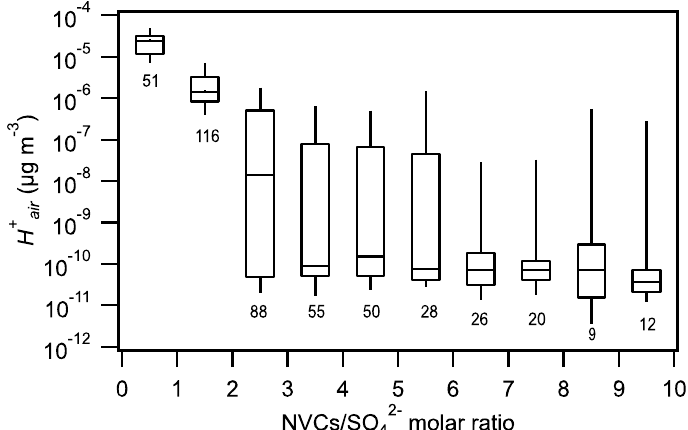
Figure 3. Box plot of 𝐻 (cid:3028)(cid:3036)(cid:3045)(cid:2878) versus the NVCs/SO 42 − molar ratio. The box plot was generated by segre- gating the data into ten equally-spaced NVCs/SO 42 − molar ratio bins. Standard box-and-whisker plots are shown, with the 90th and 10th percentile data indicated by black error bars. The top and bottom of the box are the interquartile ranges (75th and 25th percentile) centered around the median value (50th percentile). The number of points considered for each bin are also shown.